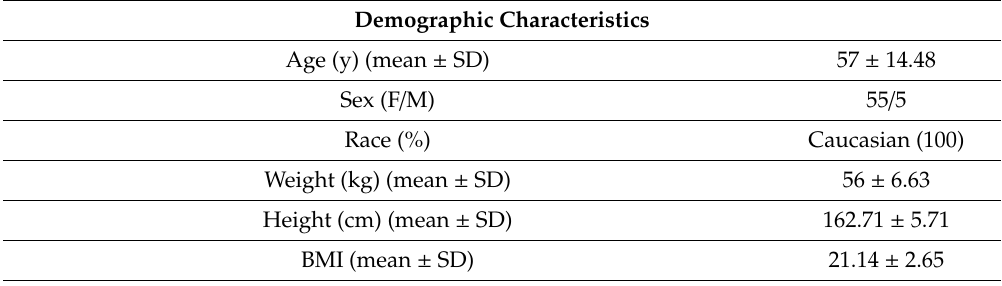
Table 1. Demographic and the clinical characteristics and laboratory